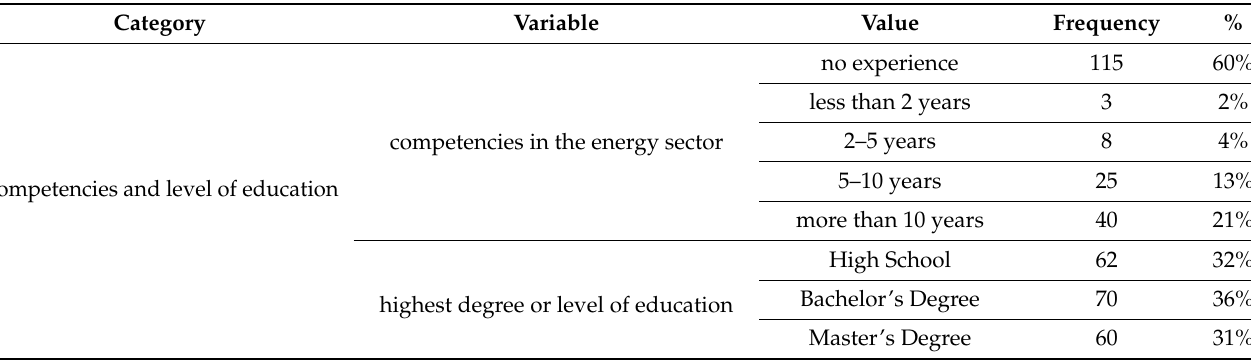
Table 4. Consumers’ competencies in the energy sector and their level of